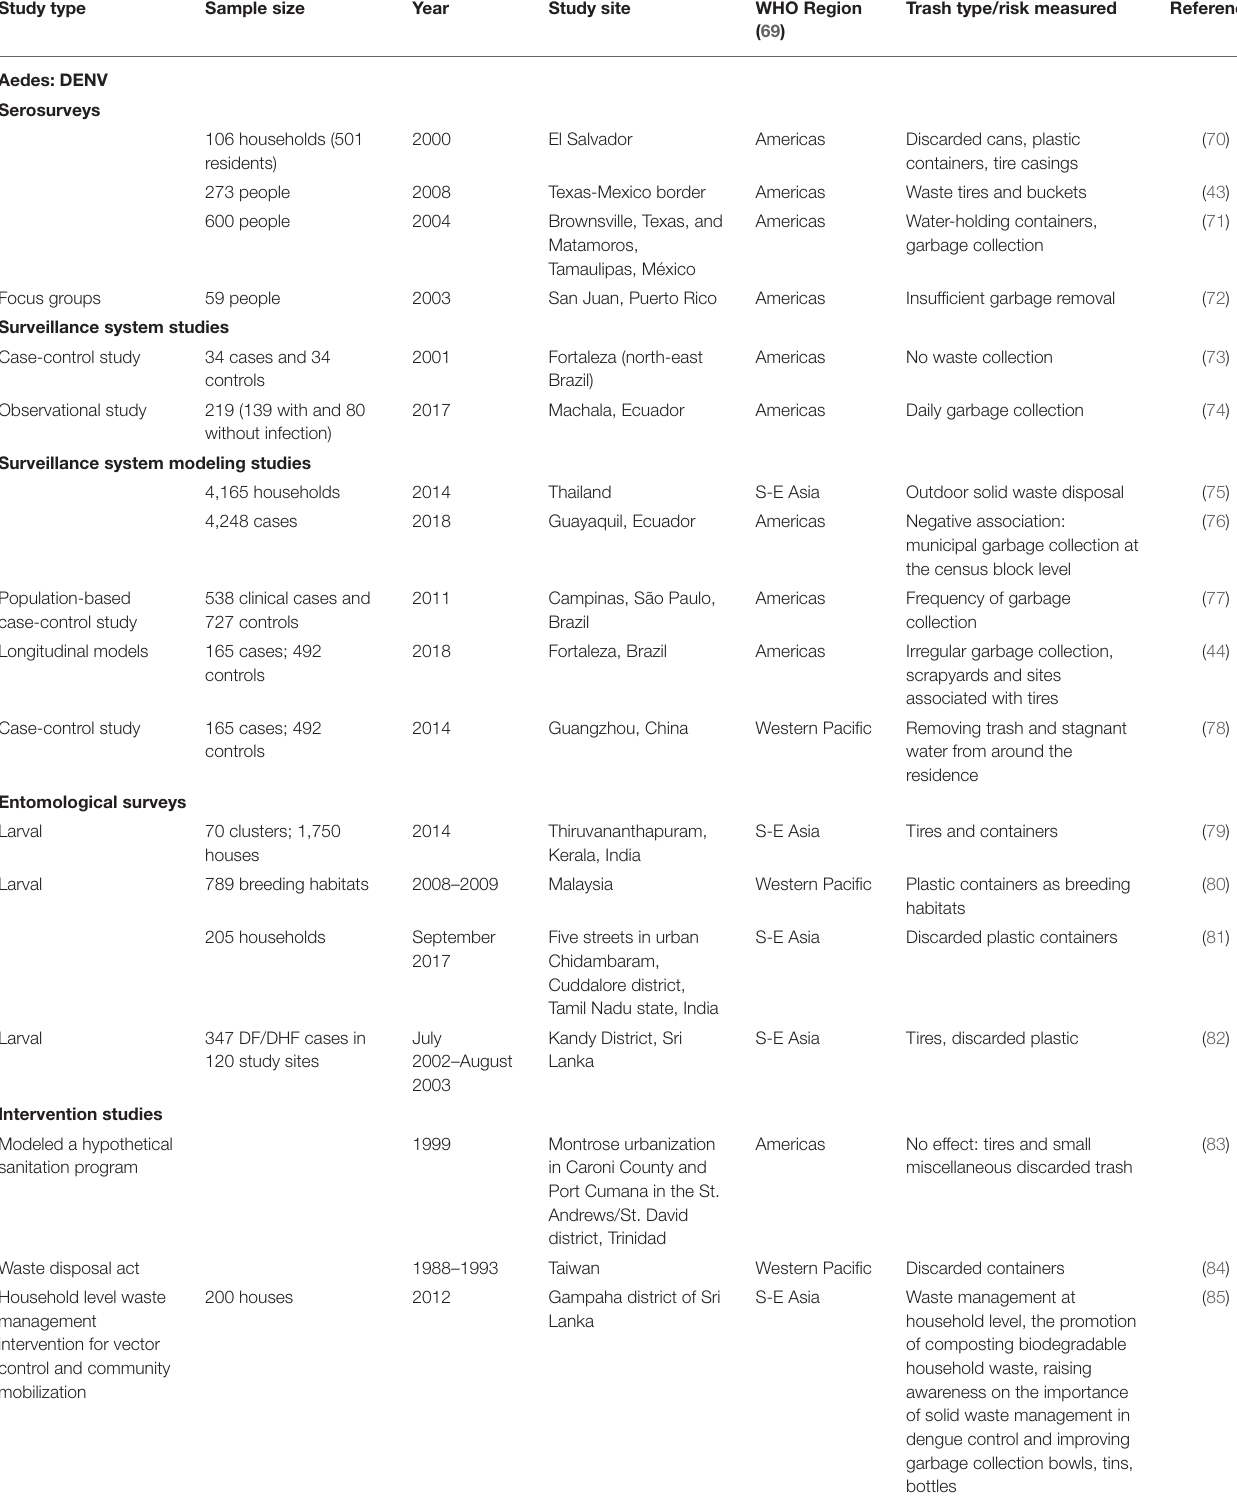
TABLE 1 | Vector-borne disease